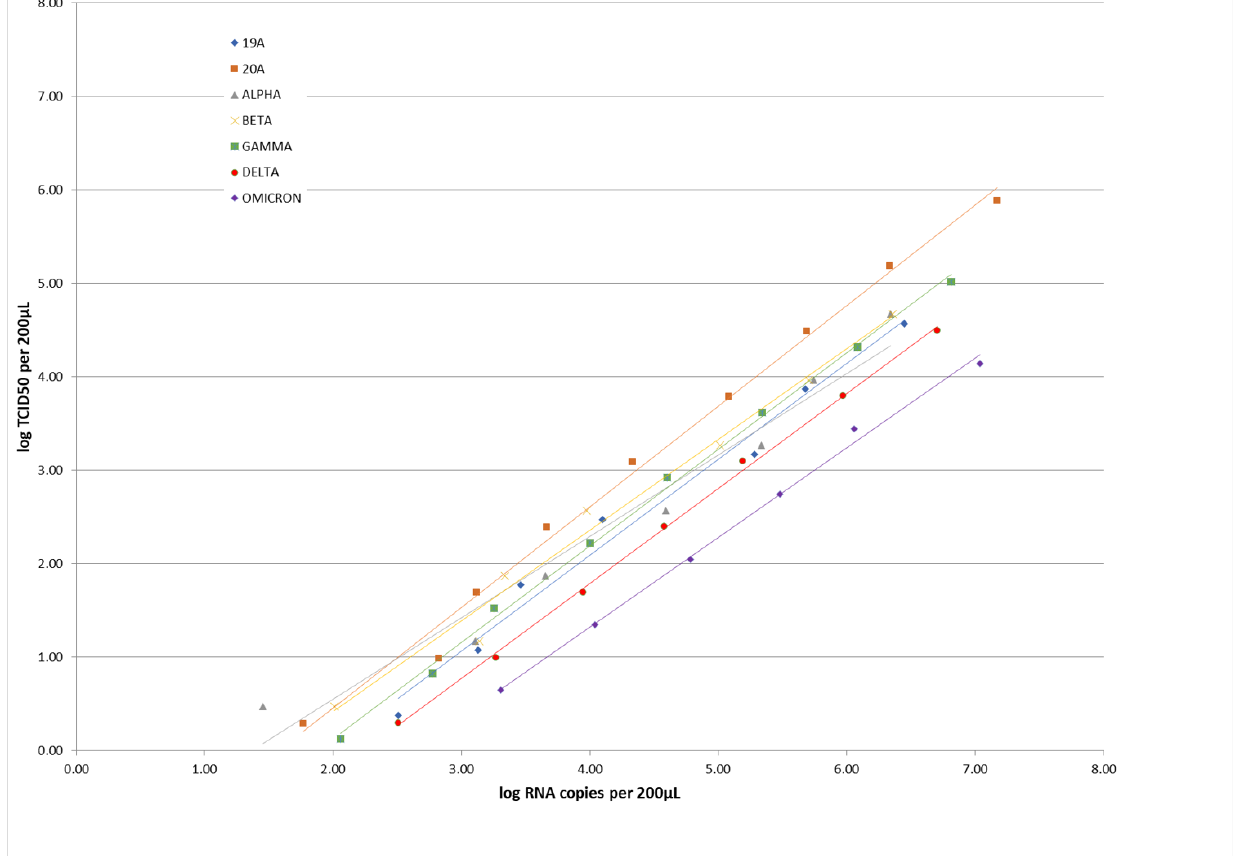
Figure 1. Correlation of the viral loads expressed as log 10 copies/200 µL and log 10 TCID 50 /200 µL for